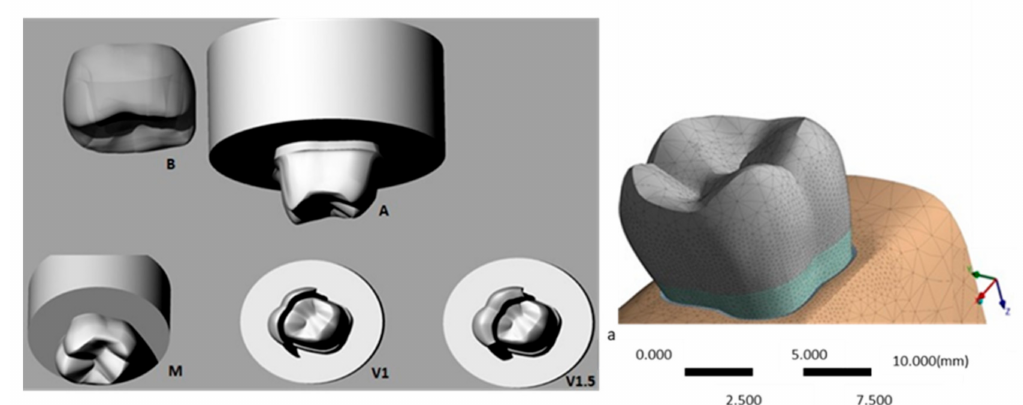
Figure 1. A . Three-dimensional models of the upper molar peripheral preparation. B . Conventional crown group; M . monolithic crown group. V1 . Zirconia crown group with buccal reduction and 1 mm occlusal extension. V1.5 . Zirconia crown with buccal reduction and 1.5 mm occlusal extension; a . 3D model with volumetric solids.